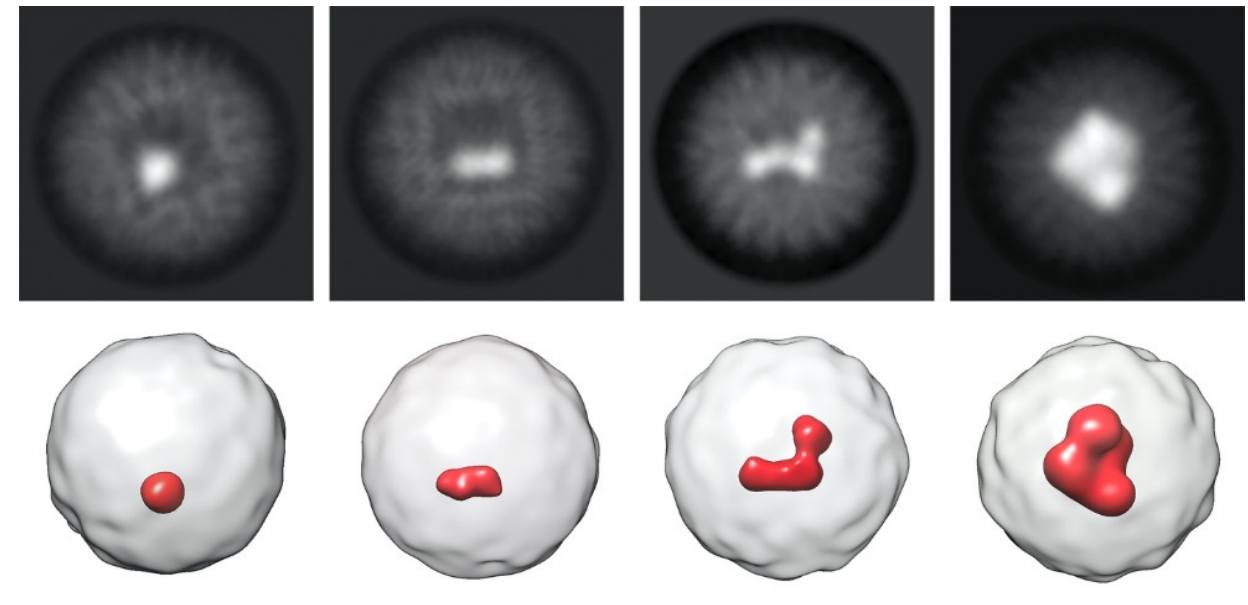
Figure 3. Cryo-EM class averages ( 1st line ) and corresponding 3D reconstructions ( 2nd line ) for different sizes of iron clusters (EMD-14948, EMD-14949, EMD-14950, EMD-14951). Dps is shown in white, Fe clusters are shown in red.